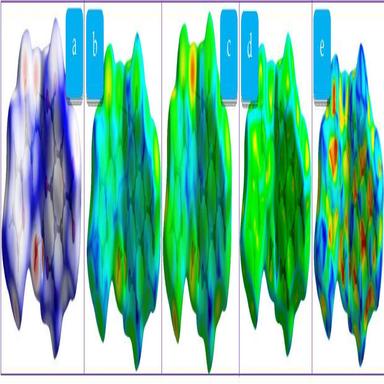
rshfeld surfaces (a) dnorm (b) di (c) de (d) curvedness (e) shape index